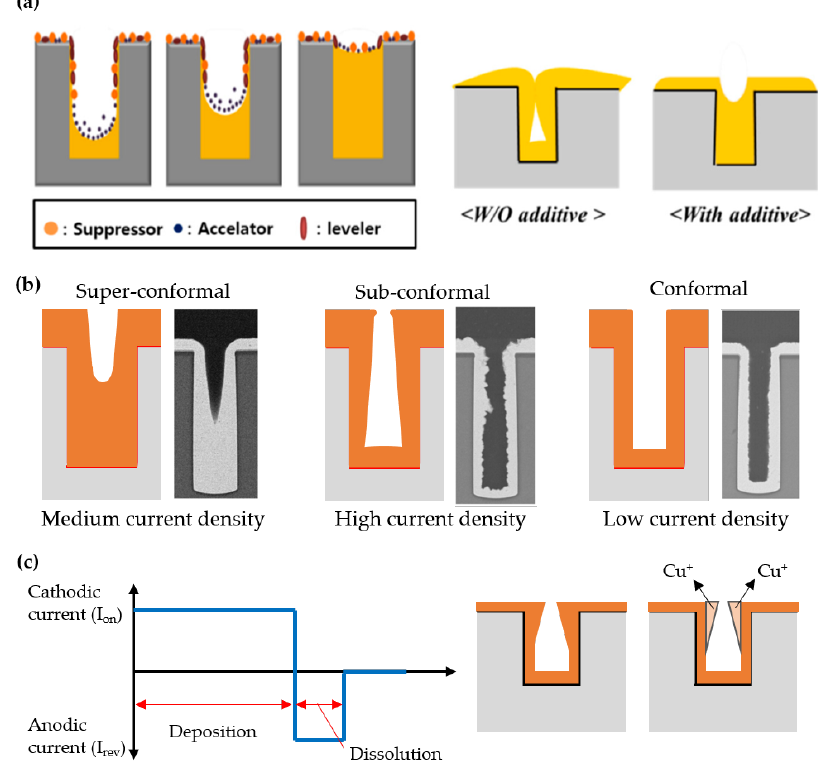
Figure 5. Schematic illustration of electroplating results corresponding to its parameters: ( a ) Additive (reprinted with permission from [51]. Copyright 2018 The Multidisciplinary Digital Publishing Institute); ( b ) Current density (reprinted with permission from [50]. Copyright 2017 Springer